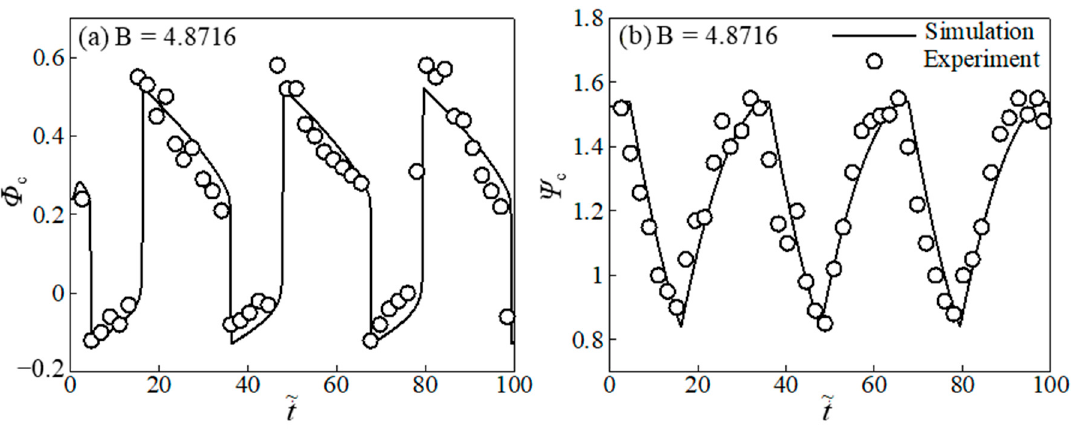
Figure 8. Transient non-dimensional ( a ) mass flow rate and ( b ) pressure rise with the experimental data and conventional model.